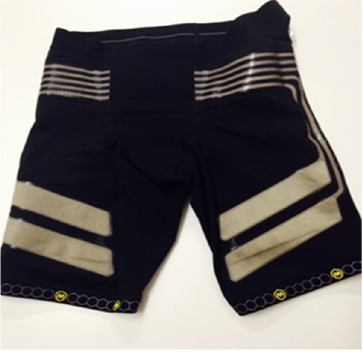
Figure 2. EMG MBody shorts on the inside.